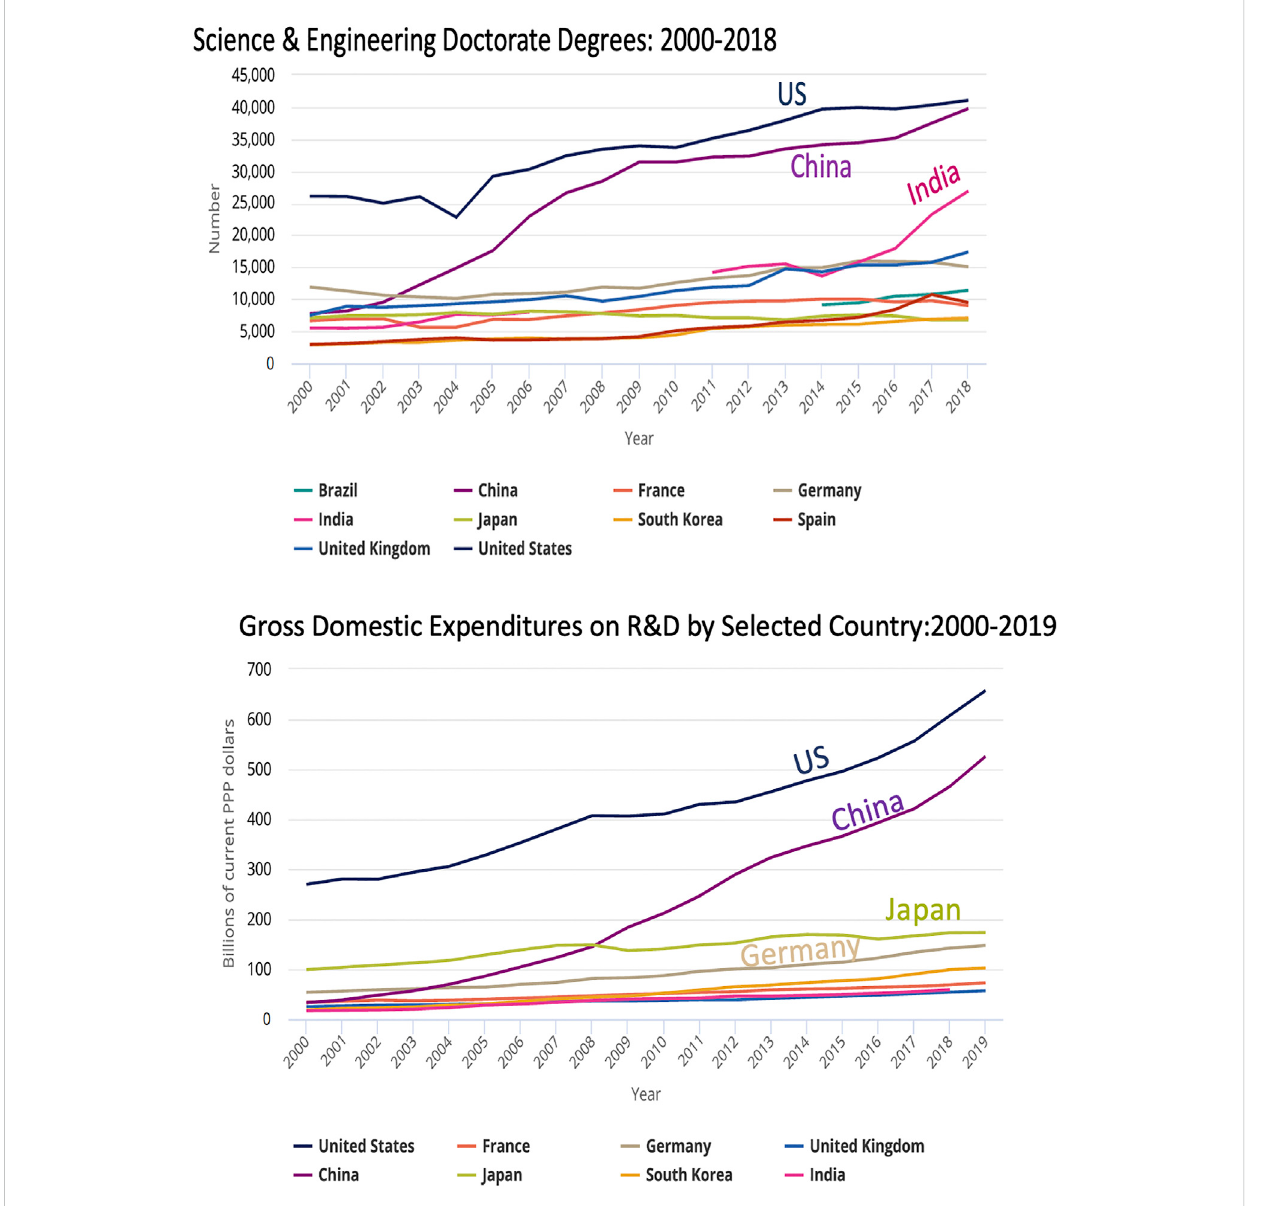
FIGURE 9 Top: Number of science and engineering degrees awarded to 10 countries. Bottom: Gross expenditures on science and engineering RandD. From National Science Board (2022).